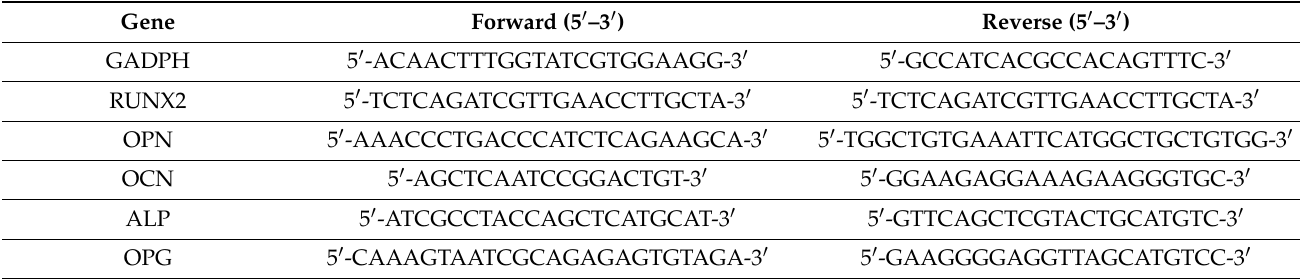
Table 1. Various primers used for qRT-PCR in this